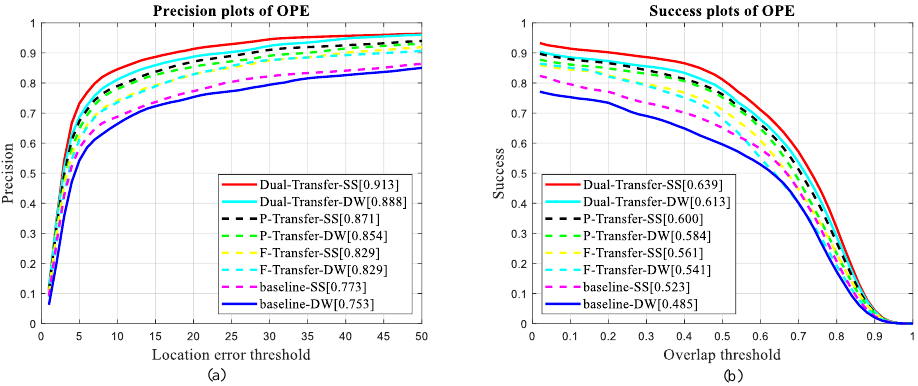
Figure 6. Precision plots ( a ) and success plots ( b ) of different variants on the HS video dataset. Feature-based transfer learning and parameter-based transfer learning are denoted as F-Transfer and P-Transfer, respectively. Depth-wise cross-correlation and spatial–spectral cross-correlation are denoted as DW and SS,